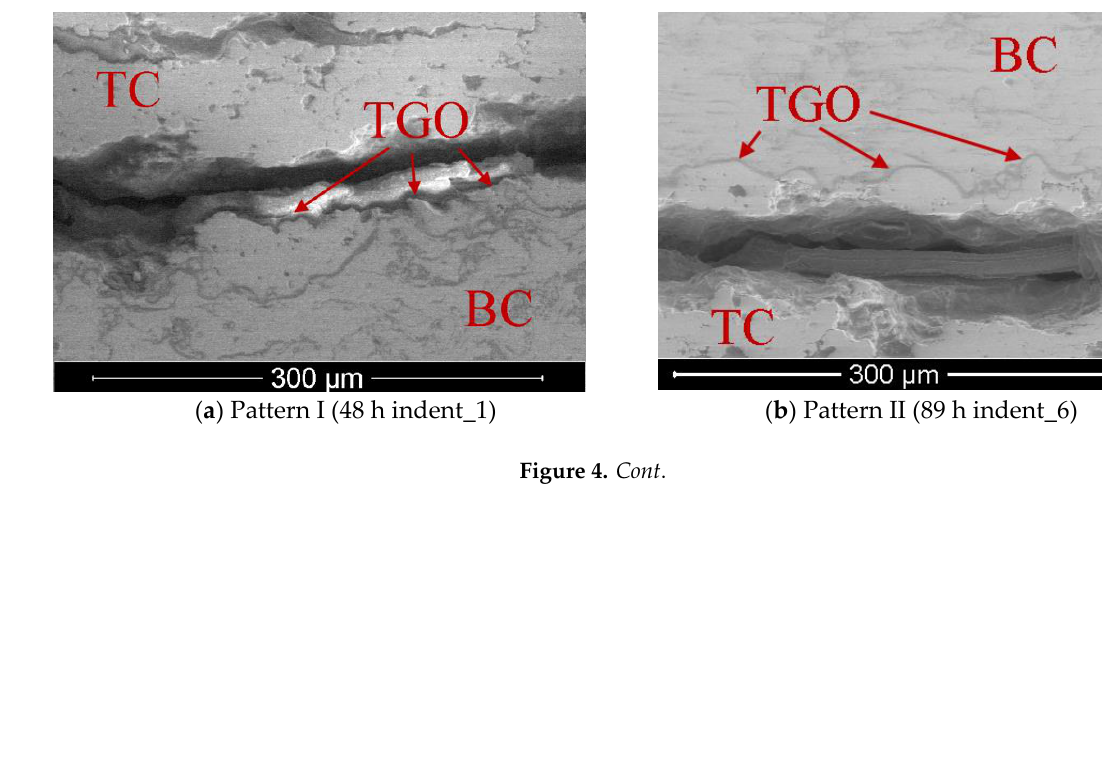
Figure 4. Crack formation patterns, depending on the aging time. TGO: thermally-grown oxide. In Pattern I (Figure 4a), the crack extended along the interface even when it was folded. With increasing aging time, diffusion took place and the BC/TC interface became more durable. In Pattern II (Figure 4b), the crack passed tangentially to the tops of interface folds, and the ceramic layer remained in the valleys. Pattern III could be distinguished (Figure 4c) at the maximum aging time, where the crack occurred only in the TC layer, tens of micrometers away from interface fold tops.